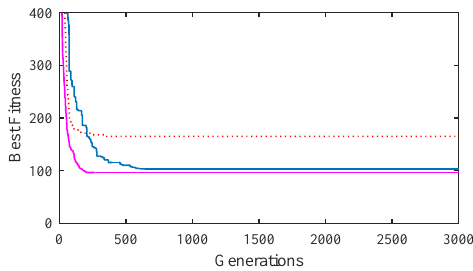
FIGURE 14: Convergence curve of all three